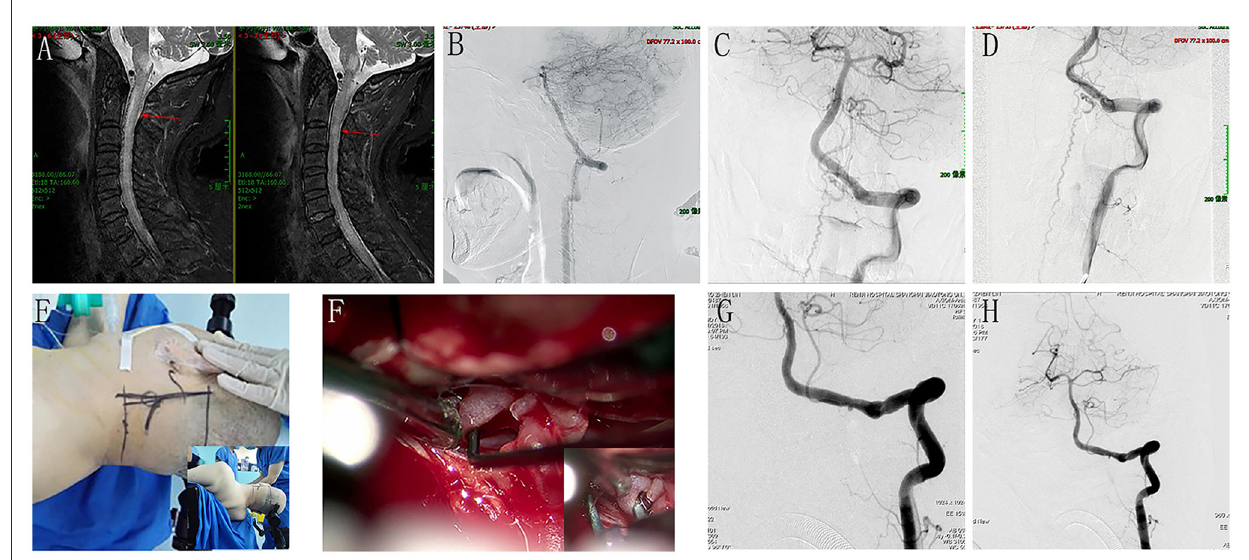
FIGURE1 Perioperative neuroimages of Case 12. A cervical spine MRI showed an expanded spinal brain stem and a longitudinal extensive cervical cord enlargement with obvious edema, and vascular flow voids was also demonstrated in front of the cervical cord (A) . The cerebral DSA demonstrated a DAVF located at the foramen magnum supplied by the meningeal branch of left VA, and the fistula was draining through the bridge-medullary veins into the dilated tortuous anterior spinal vein (B) , lateral view; (C) , anteroposterior view; (D) , oblique view with magnification. (E) showed the incision line and the operation position (park bench position). F demonstrated a large tortuous vein was visible at the level of the foramen magnum, and it originated near the dural penetration of the left vertebral artery and formed a “C” pattern crawling between the vertebral artery and the medulla. (F) showed an aneurysm min-clip was temporarily applied to the origin of the fistula to occlude the shunt. Intraoperative DSA revealed the complete disappearance of the DAVF (G) . After electrical coagulation and disconnection of the fistula at its origin from the dura, repeat cerebral DSA confirmed the complete obliteration of the fistula (H)